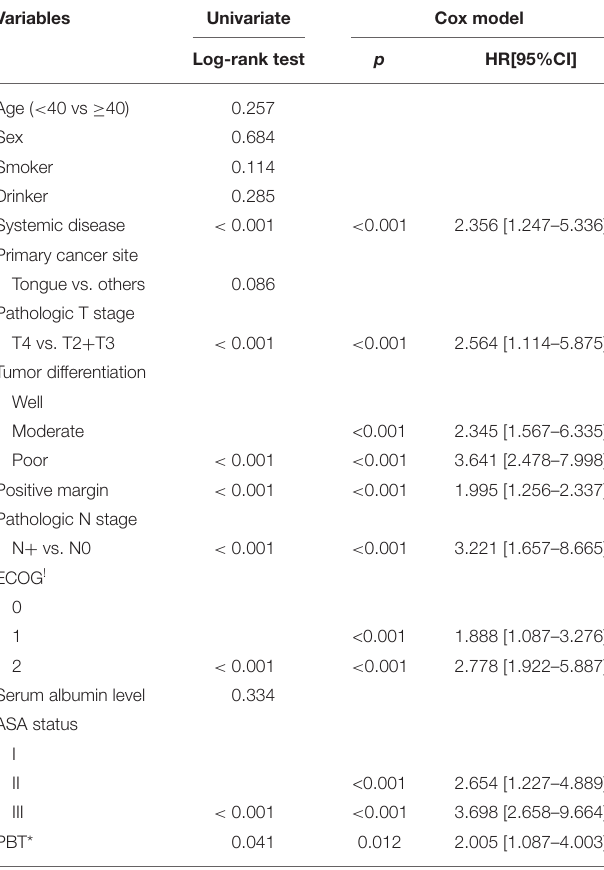
TABLE 3 | Univariate and cox model analyses of disease specific survival in the 423 enrolled patients. Variables